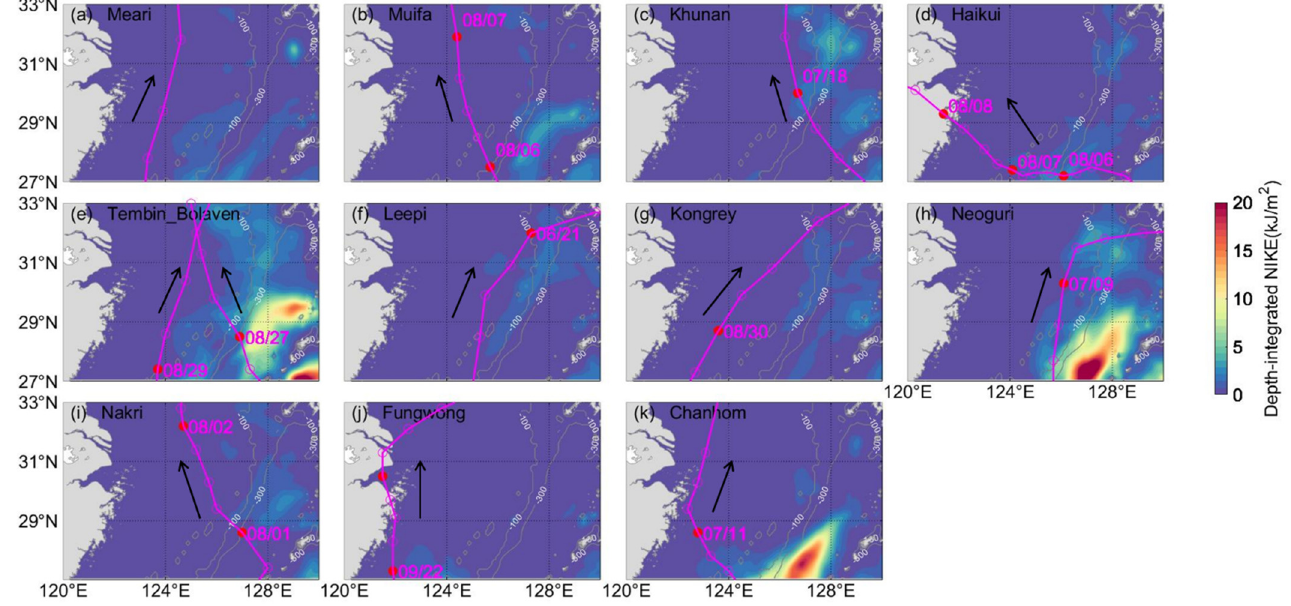
Figure 6. Depth-integrated NIKE of the 12 typhoons: ( a ) Meari, ( b ) Muifa, ( c ) Khunan, ( d ) Haikui, ( e ) Tembin_Bolave, ( f ) Leepi, ( g ) Kongrey,( h ) Neoguri, ( i ) Nakri, ( j ) Fungwong and ( k ) Chanhom. The NIKE was averaged in the 7 days after the passage of the typhoon. The black arrow(s) in each subfigure denotes the moving direction of the typhoon(s).